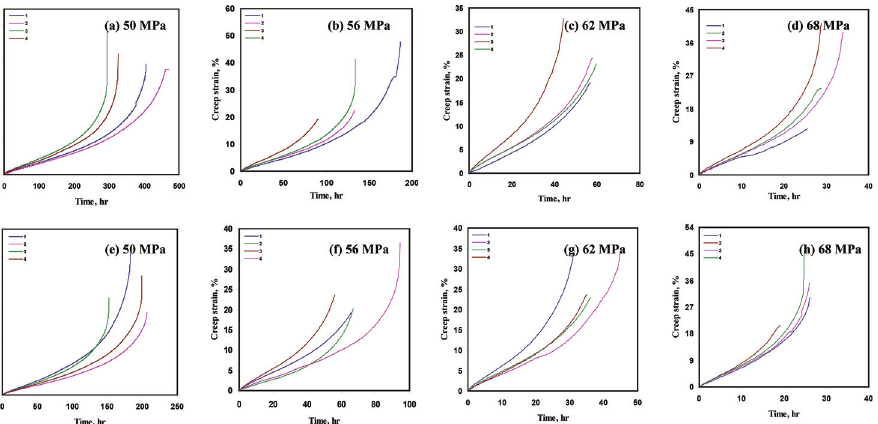
Figure 3: (a – d) Scatter creep curves at 870°C and at various stress levels of 11 years service exposed primary reformer tubes (top region); (e – h) Scatter creep curves at 870°C and at various stress levels of 11 years service exposed primary reformer tubes (bottom region); (i – l) Creep strain rate curves at 870°C and at various stress levels of 11 years service exposed primary reformer tubes (top region); (m – p) Creep strain rate curves at 870°C and at various stress levels of 11 years service exposed primary reformer tubes (bottom